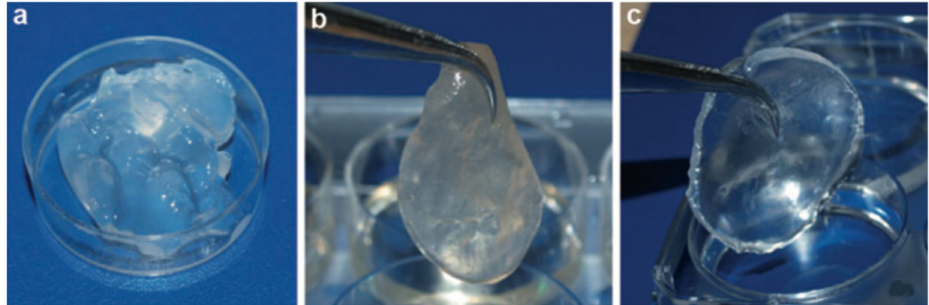
Figure 1. Collagen hydrogels: ( a ) non-cross-linked, ( b ) glutaraldehyde cross-linked and ( c ) EDC/NHS cross-linked